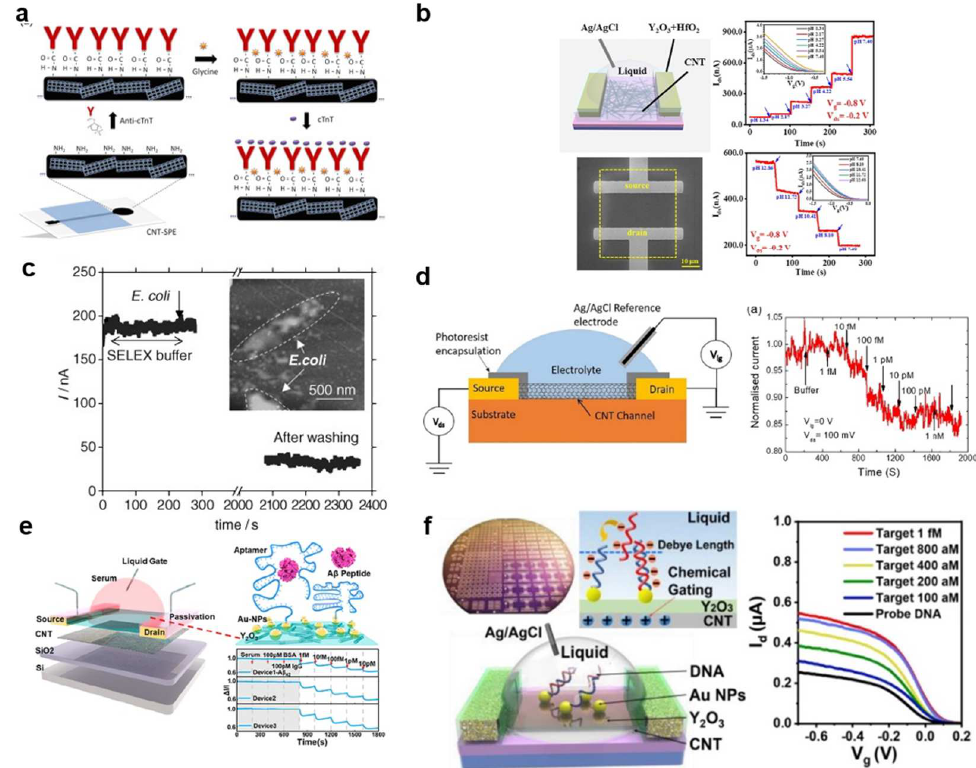
Figure 9. Bio–CNTFETs have been used in the diagnosis of viruses, ions, proteins, antibodies, and cells. ( a ) Detection of protein [146]. (Copyright © 2013, Talanta.) ( b ) Monitor the PH of the solution [148]. (Copyright © 2023, Carbon.) ( c ) The detection of biological cells [147]. (Copyright © 2008, Small 2008.) ( d ) The selective detection of SARS-CoV-2 [149]. (Copyright © 2021, A proof-of-concept study. Materials Today: Proceedings.) ( e ) Early diagnosis and large-scale screening of AD [56]. (Copyright © 2022, ACS sensors.) ( f ) The detection of specific DNA sequences and MVs [90]. (Copyright © 2020, ACS nano.)